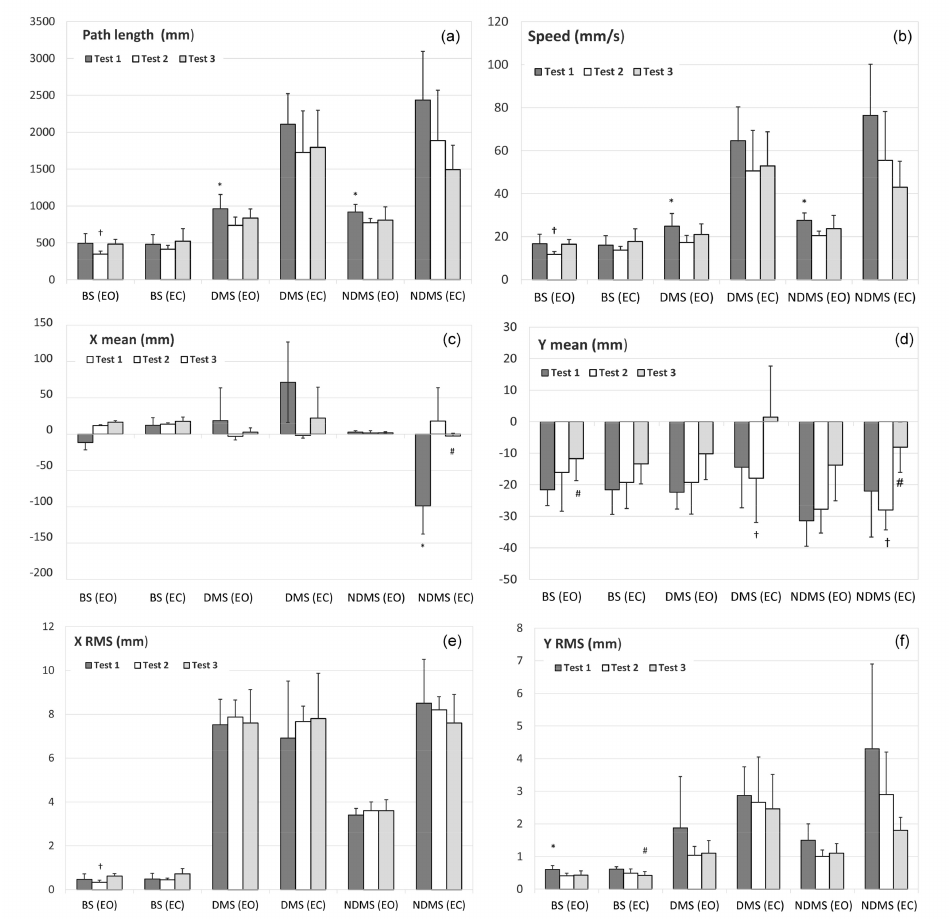
Figure 2. Stabilometric variables compared for bipedal stance (BS), dominant monopedal stance (DMS), and non-dominant monopedal stance (NDMS) for eyes open (EO) and eyes closed (EC) in baseline (Test 1), post-balance (Test 2) and post-sand (Test 3) tests. ( a ) Path length, ( b ) Speed, ( c ) X mean, ( d ) Y mean, ( e ) X RMS and ( f ) Y RMS. * = significant di ff erence between Test 1 and 2; † = significant di ff erence between Test 2 and 3; # = significant di ff erence between Test 1 and 3. Significance: p <